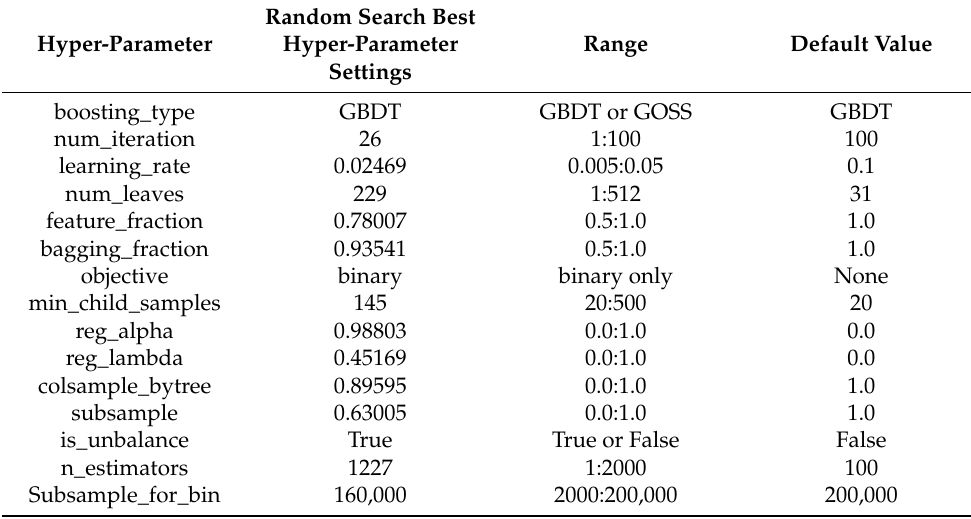
Table 8. LightGBM AHBO-TPE Search Hyper-parameter Results (Ember